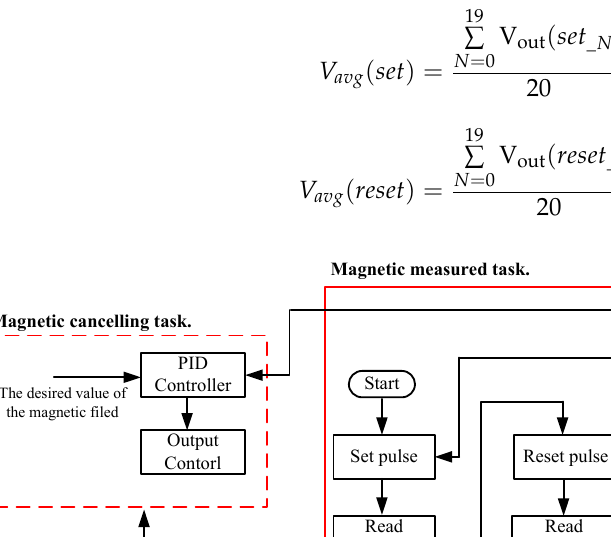
Figure 4. The implementation of the amplifier with gain control.